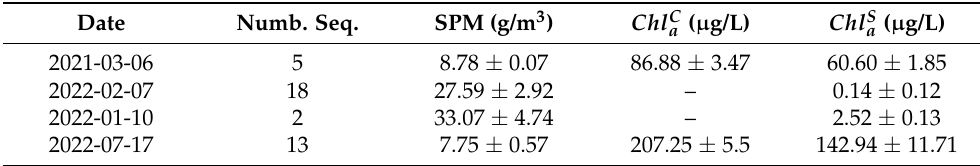
Table 2. Mean and standard deviation of SPM and Chl a concentrations retrieved with the CRAT and SIMIS algorithm on different dates (see orange bars in Figures 7 and 9, and associated reflectance spectra in Figure